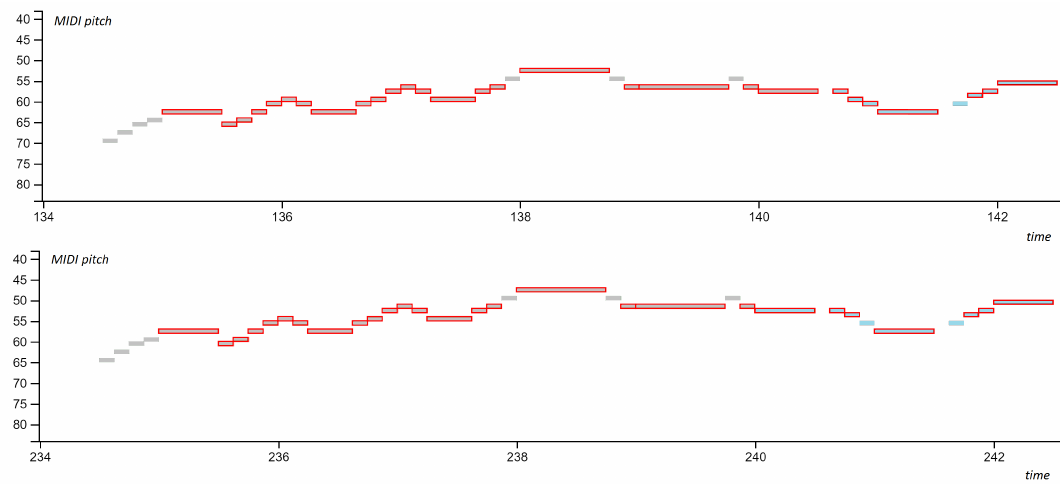
Figure 3. An incomplete pattern match of two pattern occurrences in Bach BWV 889 Fugue in A minor (from the JKU PDD dataset). Two pattern occurrences are presented in the figure (top and bottom). A piano roll representation is shown where the reference annotation is coloured in grey and the identified pattern occurrences outlined with red borders. Even though similar, events on the right side (shown in light blue) are not part of the reference annotations, however they are included in the model’s patterns due to their co-occurrence with other